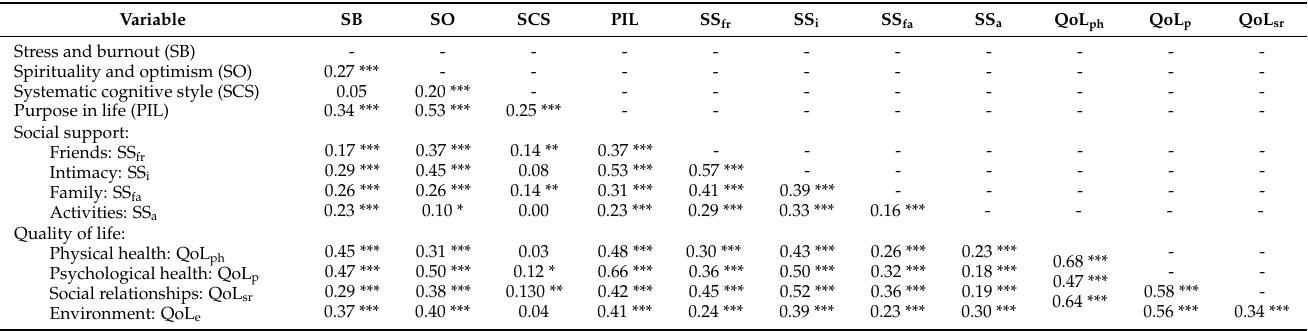
Table 4. Pearson’s correlation coefficients between studied variables (working people).